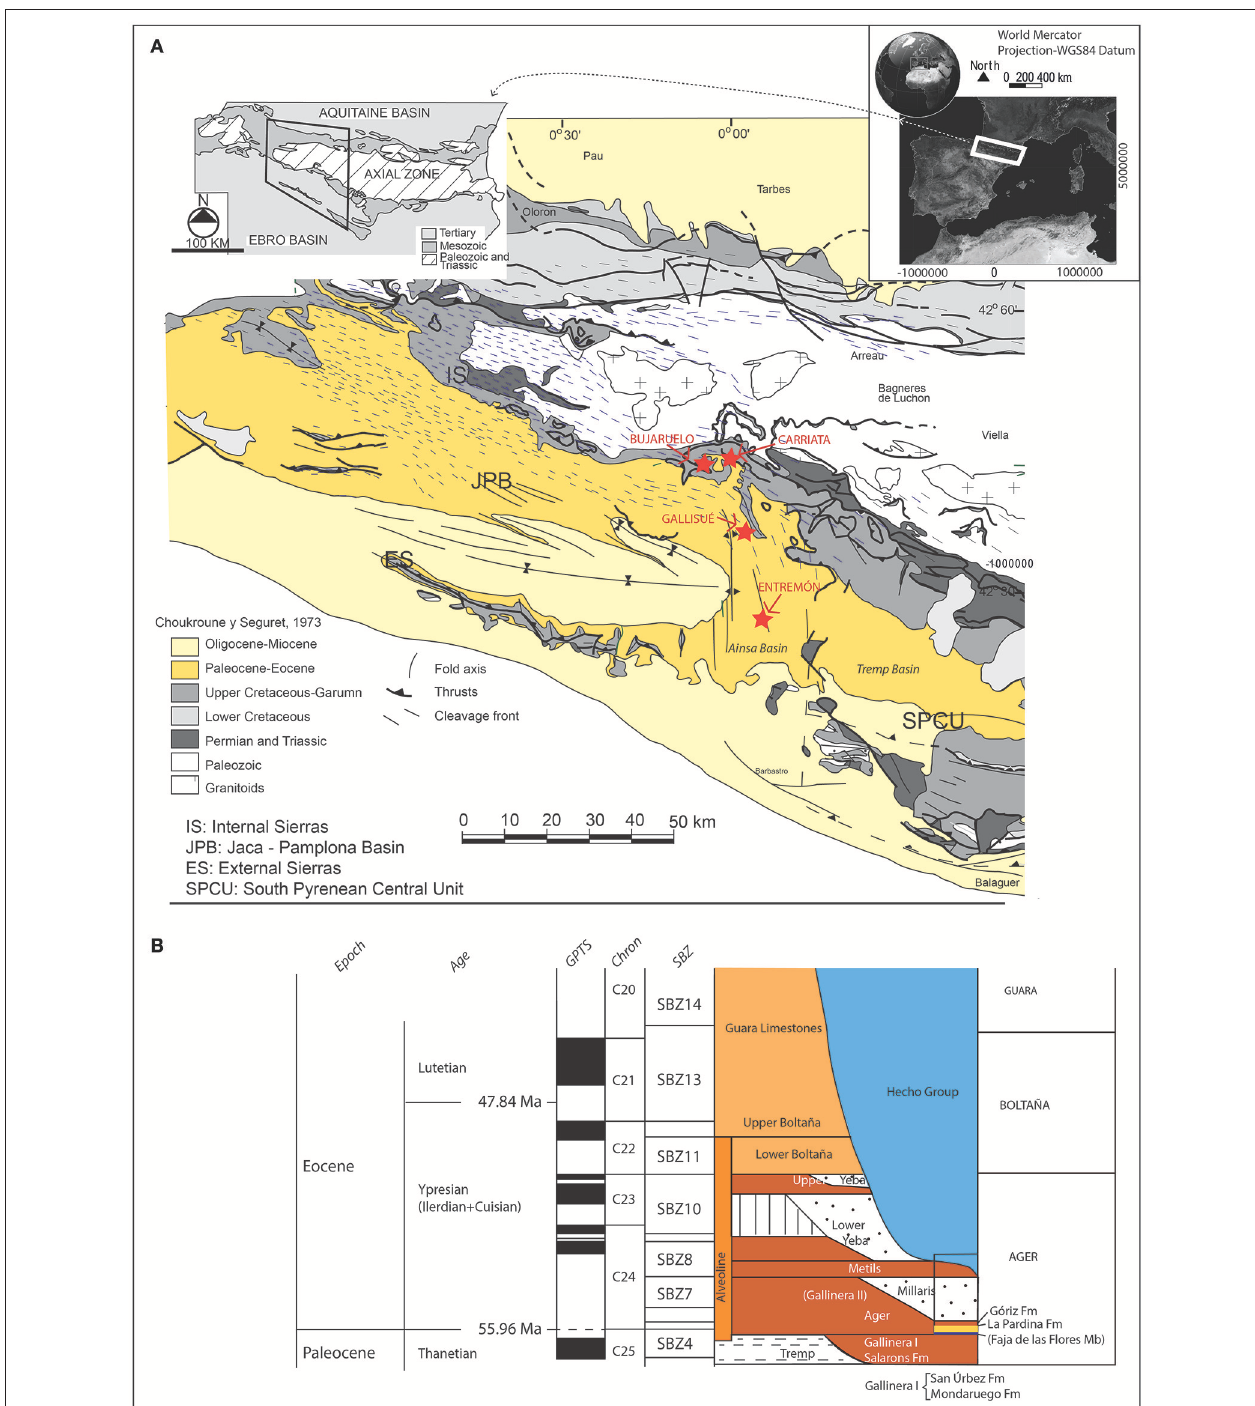
FIGURE 1 | (A) Present-day location of the studied section (red stars) in the geological map (modified from Choukroune and Séguret, 1973) where the regional cleavage planes are marked with short blue lines. (B) The PETM general stratigraphy modified from Barnolas and Gil-Peña (2001), Robador et al. (2010), and Pujalte et al. (2016). Epoch, Age, Geomagnetic Polarity Time Scale (GPTS), C: chrons, and SBZ: Shallow Benthic Zones (SBZ) (Serra-Kiel et al., 1998). Brown colors represent limestones; blue and white colors represent turbiditic deposits. Formation names and litostratigraphic units are represented.